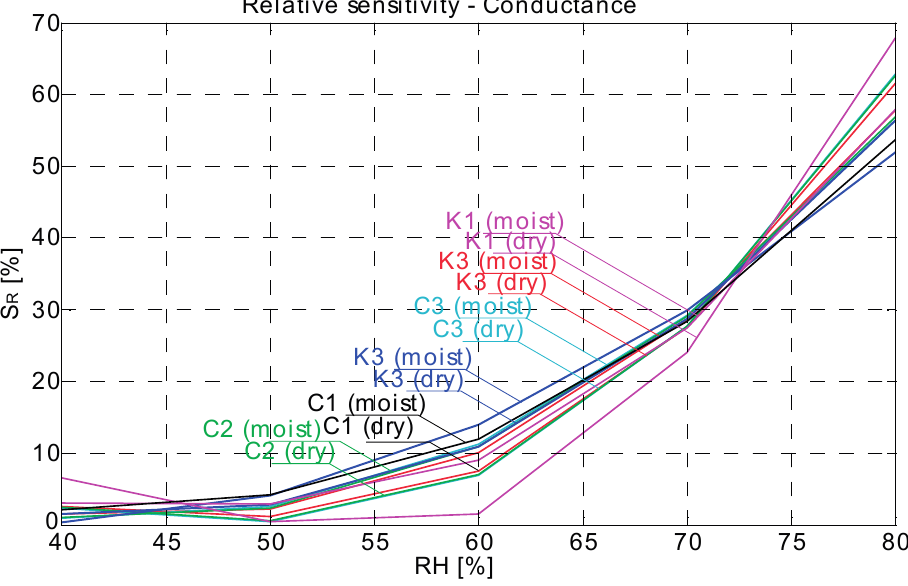
Figure 10. Relative rate of change of conductance for comb type